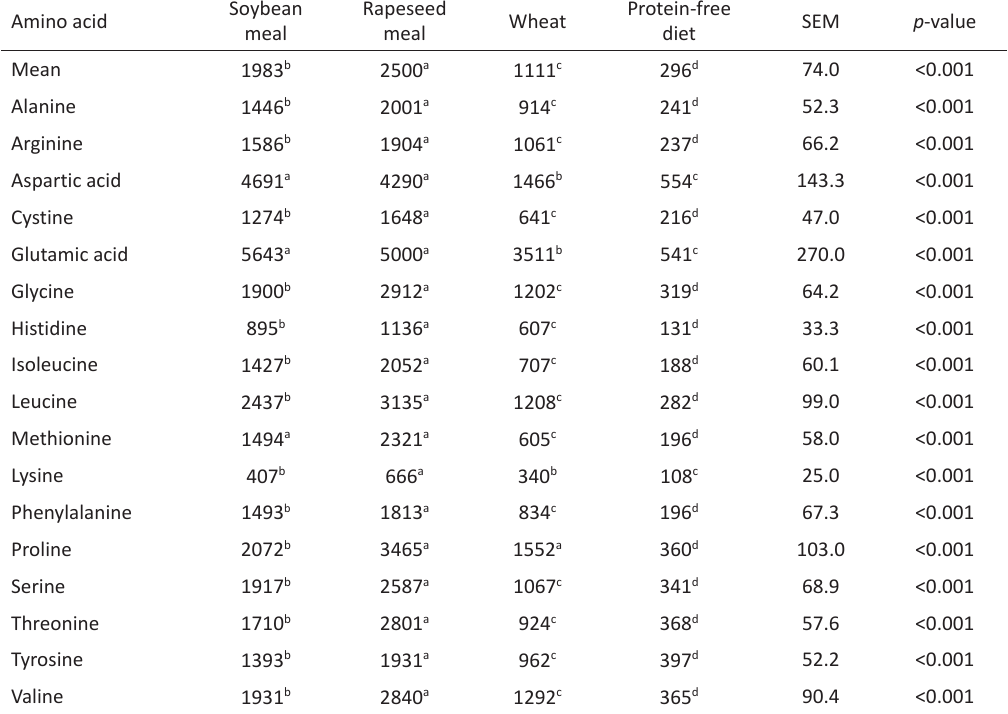
Table 5. Amino acid flows (mg kg -1 dry matter intake) in broilers fed soybean meal, rapeseed meal, wheat, or protein- free diet (n=4 per treatment)